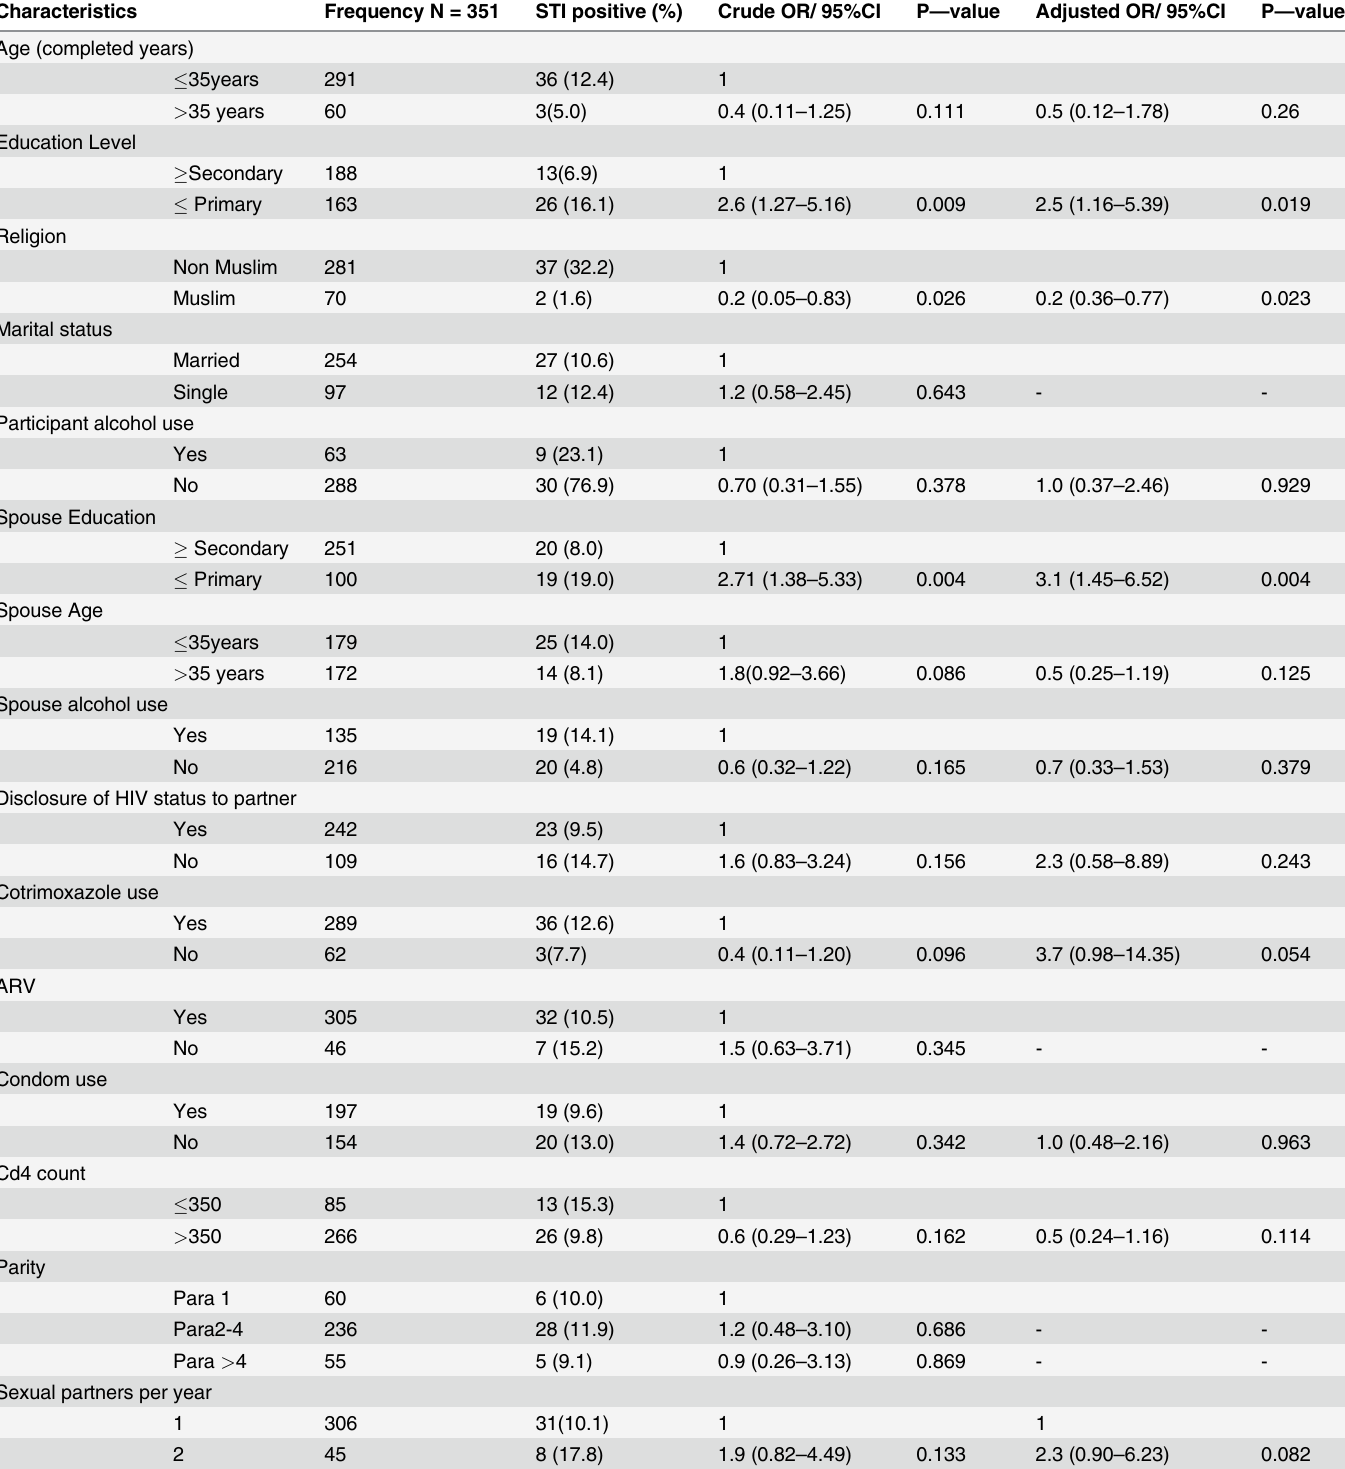
Table 3. Factors associated with STIs among women living with HIV adjusted for all other variables in the model.